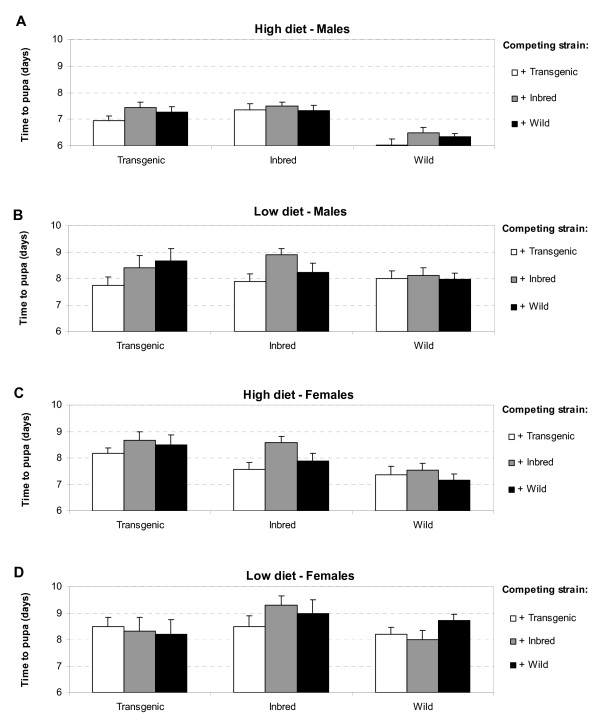
Least squares means (±SE) of time from egg hatch to pupation (development time) of Ae. aegypti. (A) Development time of males at high diet levels, (B) of males at low diet levels, (C) of females at high diet levels and (D) of females at low diet levels. Each bar represents one treatment combination consisting of strain and presence of competing strain.